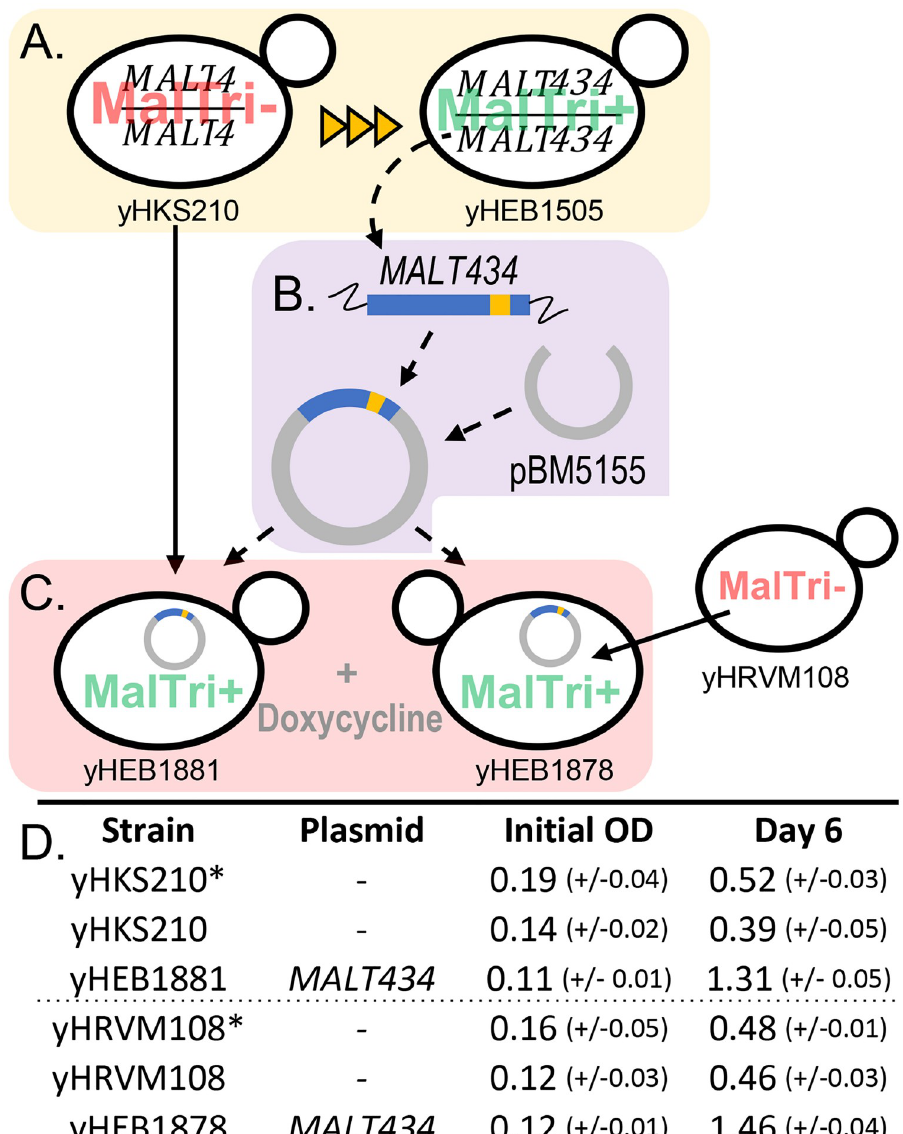
Fig 5. Heterologous expression of MALT434 . A) Evolution of non-maltotriose utilizing strain (MalTri-), WI- Seub (yHKS210), to maltotriose utilizing (MalTri+) strain, yHEB1505, by serial passing on maltotriose containing media (same as Fig 3A). B) Insertion of MALT434 into vector pBM5155 for doxycycline-inducible heterologous expression in MalTri- strains. C) Transformation of MALT434 expression plasmid in MalTri- S . eubayanus strains yHKS210 and NC- Seub (yHRVM108). D) Table of initial and day-six OD 600 (OD) measurements of parent strains and strains carrying the MALT434 expression plasmid grown in SC media with maltotriose as the sole carbon and doxycycline to induce plasmid expression. N = 3, standard deviation in parentheses. � Control grown in SC + 0.04% glucose + doxycycline to reflect the approximate amount of growth expected from contamination with other carbon sources when using 98% pure